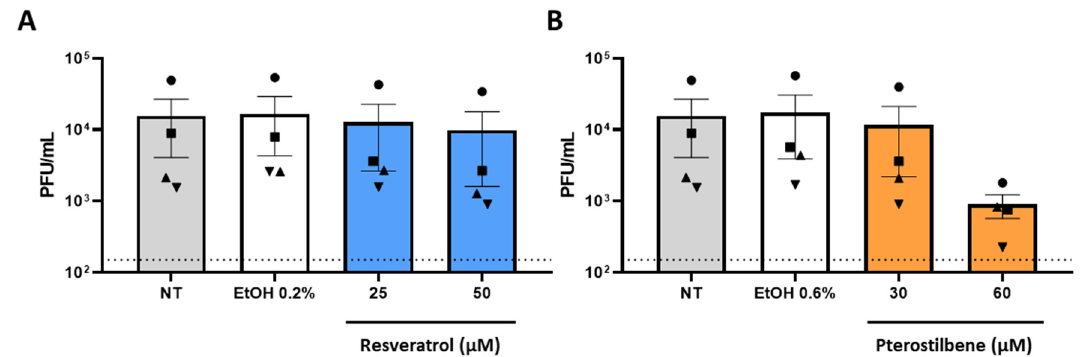
Figure 3. Resveratrol and pterostilbene do not significantly inhibit SARS-CoV-2 infection in Calu-3 cells. Calu-3 cells were inoculated with SARS-CoV-2 MOI 1 in the absence (non-treated, NT) or presence of ( A ) 25 or 50 µM resveratrol, ( B ) 30 or 60 µM pterostilbene, or ( A , B ) the equivalent volumes of EtOH. Virus particle production was determined at 8 hpi by plaque assay. Data are represented as mean ± SEM, symbols represent four independent experiments. Dotted line indicates the threshold of detection. Student T test was used to evaluate statistical differences and a p value ≤ 0.05 was considered significant. In the absence of ‘*’ the data is non-significant.